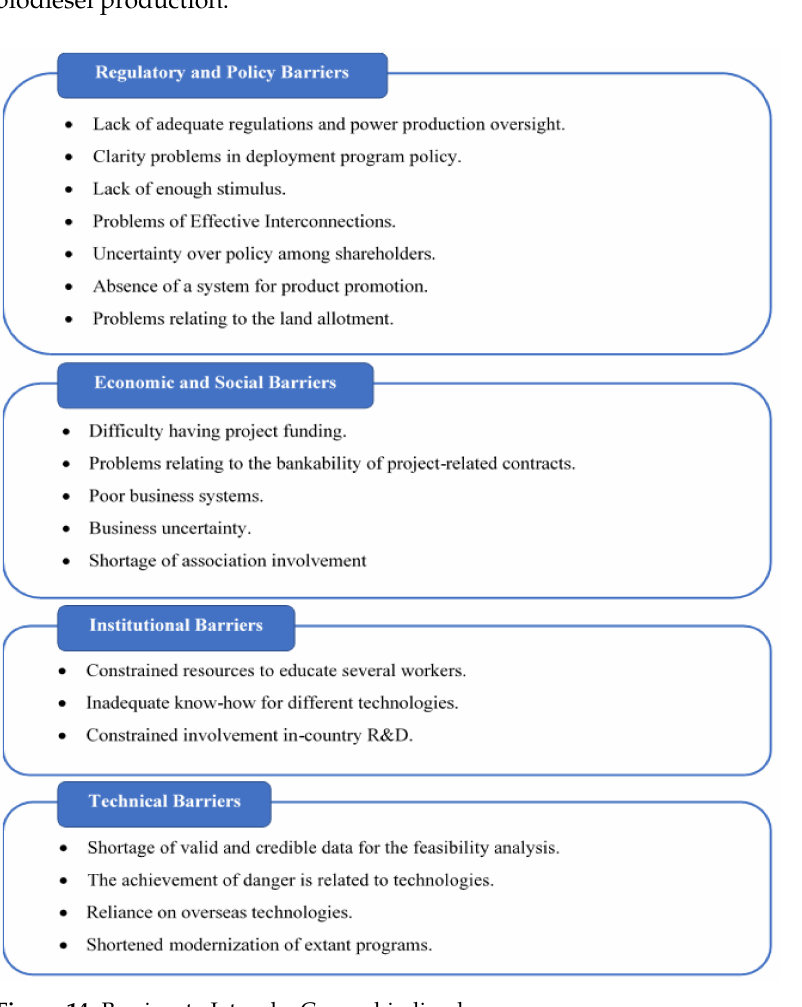
Figure 14. Barriers to Jatropha Curcas